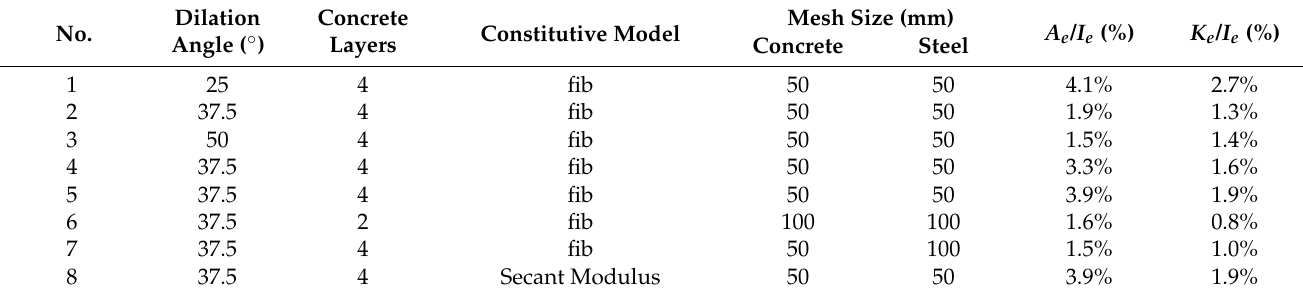
Table 1. Results of sensitivity